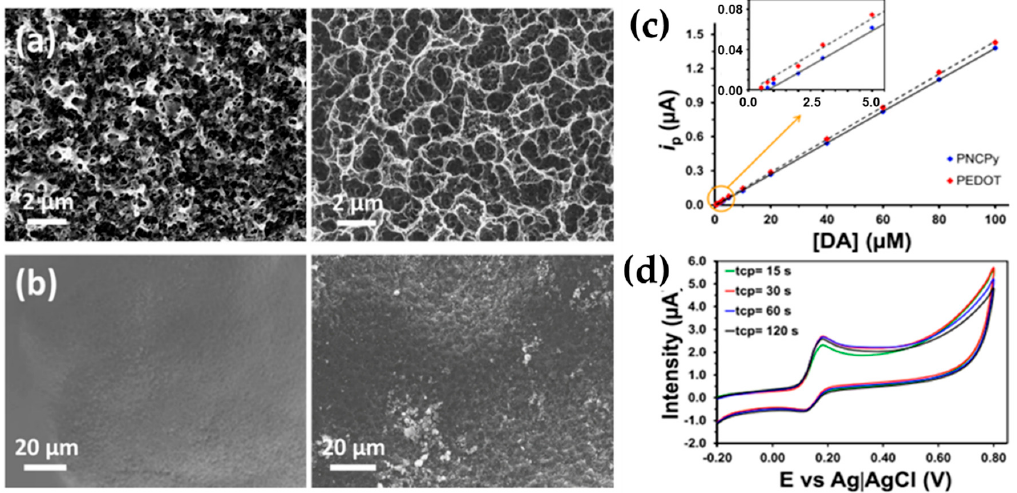
Figure 16. SEM micrographs of ( a ) poly(3,4-ethylenedioxythiophene) (PEDOT) and ( b ) poly(N-cyanoethylpyrrole) (PNCPy) before (left) and after (right) plasma treatment using t cp = 2 min. ( c ) DA detection limit of PEDOT- and PNCPy-modified glassy carbon electrodes (GCEs) with cold- plasma treatment, as obtained from the standard addition of 10 µ L of DA to 10 mL of 0.1-M PBS. Anodic peak intensity (i p ) was determined by CV using a scan rate of 50 mV s − 1 ; ( d ) control voltammograms of 100 µ -M DA in 0.1-M PBS at cold-plasma treated PEDOT-modified GCE prepared using di ff erent t cp values. Scan rate: 100 mV / s. Reprinted with permission from reference [48]. Copyright © 2016 Elsevier